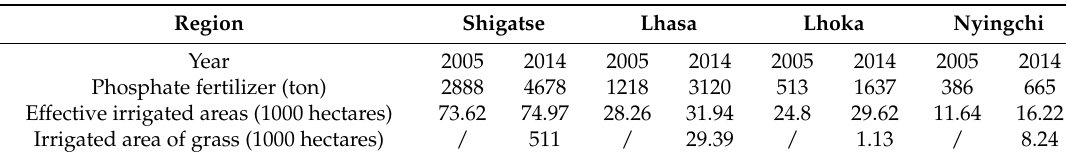
Table 4. Fertilizer application and land